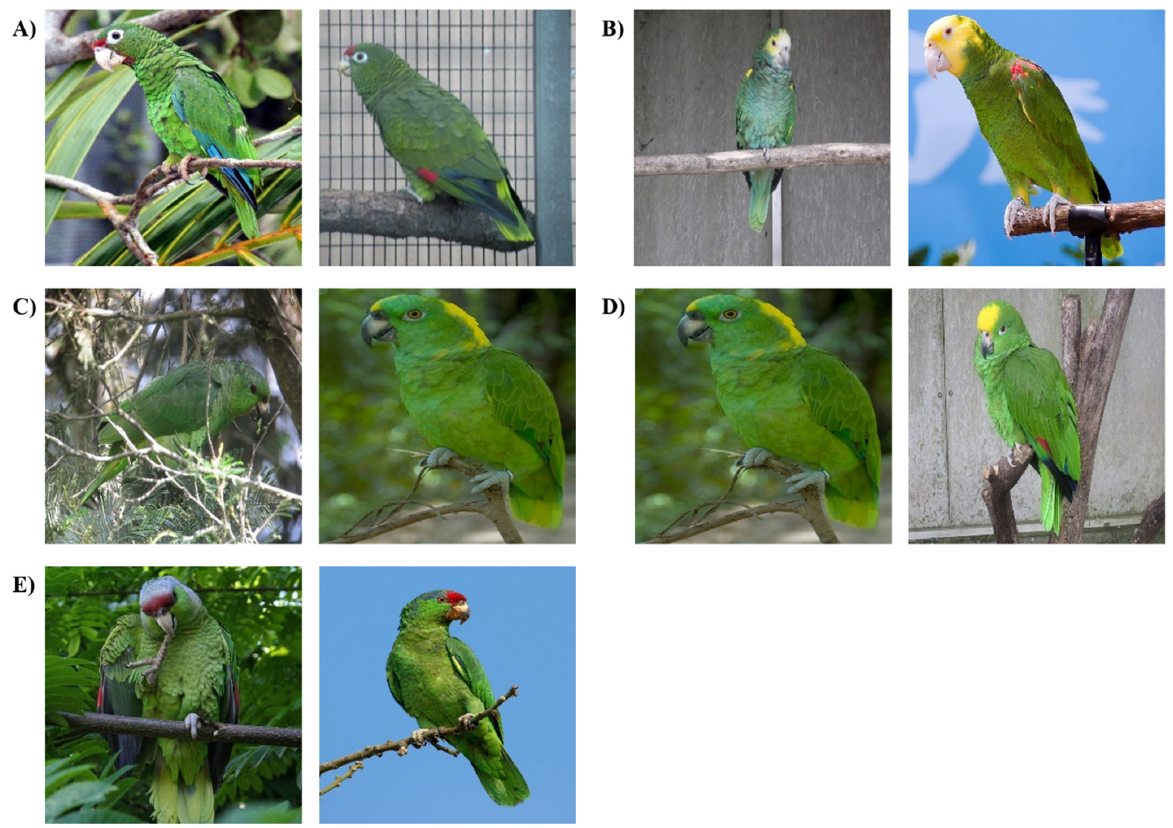
Figure 4. Representative images of the top five results for incorrect classification using the DenseNet121 model. Images on the left and right represent the true and predicted results, respectively. ( A ) Amazona vittata (left) was predicted to be Amazona tucumana (right). ( B ) Amazona barbadensis (left) was predicted to be Amazona oratrix (right). ( C ) Amazona mercenarius (left) was predicted to be Amazona auropalliata (right). ( D ) Amazona auropalliata (left) was predicted to be Amazona ochrocephala (right). ( E ) Amazona finschi (left) was predicted to be Amazona viridigenalis (right). Photo credits: ( A ) Tom MacKenzie (left), Carlos Urdiales (right); ( B ) Em ő ke Dénes (left), David J. Stang (right); ( C ) Félix Uribe (left), Andrew Gwozdziewycz (right); ( D ) Andrew Gwozdziewycz (left), MAClarke21 (right); and ( E ) Cédric Allier (left), Roger Moore (right).